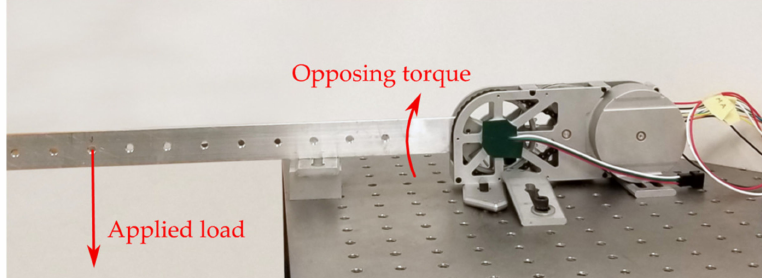
Figure 3. Experimental setup for the static torque test, showing the applied load on actuator arm and opposing actuator